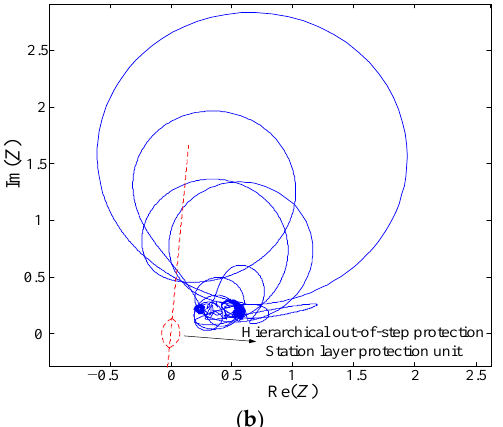
Figure 12. Measured impedance trajectory and the station layer protection action characteristics at each bus: ( a ) measured impedance trajectory at M1 and the station layer out-of-step protection action characteristics and ( b ) measured impedance trajectory at M2 and the station layer out-of-step protection action characteristics.